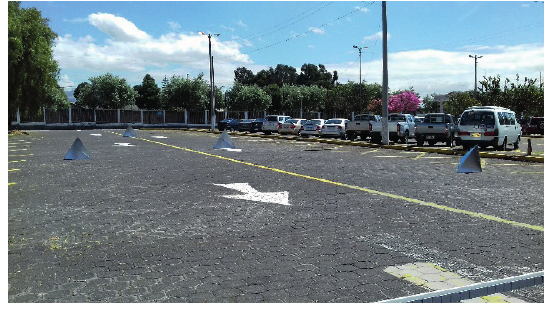
Figure 12. Probing polygon